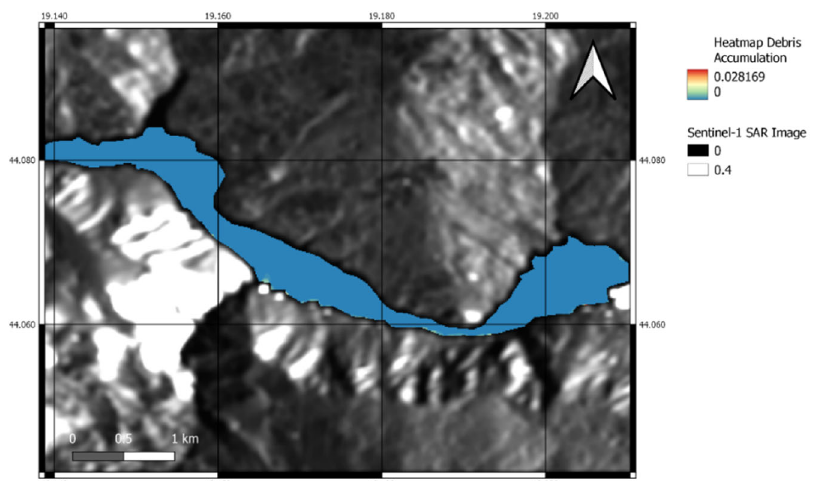
Figure 17. Heatmap of Drina River system and Bajina Basta hydroelectric dam near Peru ć ac, Serbia, from 5 January 2019 to 26 December 2021 (total 142 acquisitions). Basemap: multitemporal average of Sentinel-1 VV images. Colour: heatmap. (Sentinel-1, Credits: ESA).